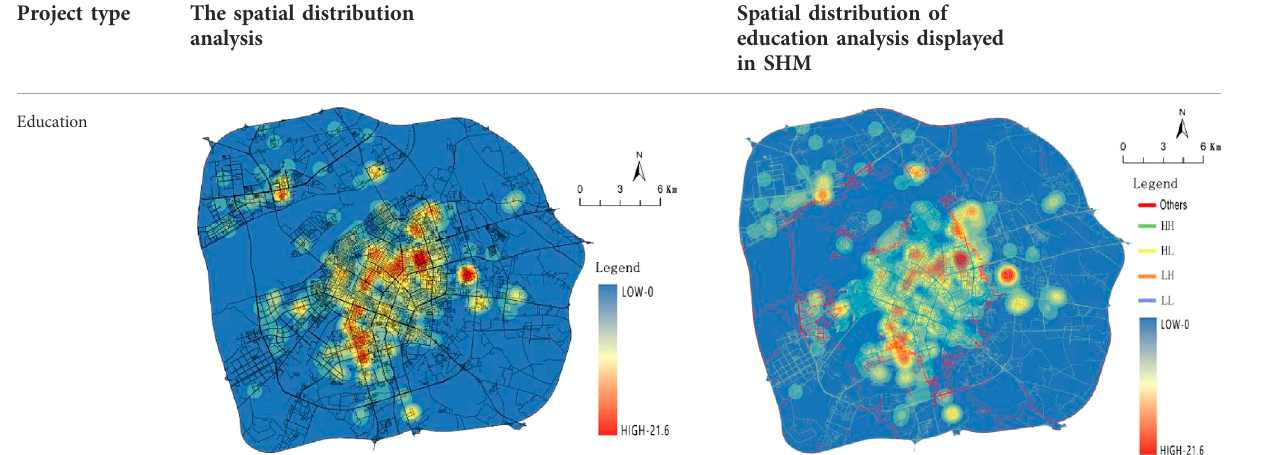
TABLE 6 Spatial distribution of single infrastructure (Education) in